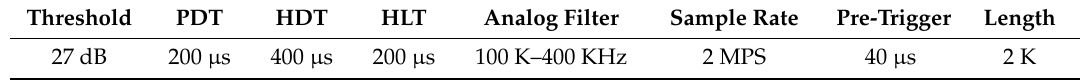
Figure 1. Schematic diagram of the acoustic emission (AE) monitoring of pitting corrosion: ( a ) Q235 specimen (dimension in mm), ( b ) pitting assembly, and the AE system and potential measurement. Table 2. AE acquisition options.